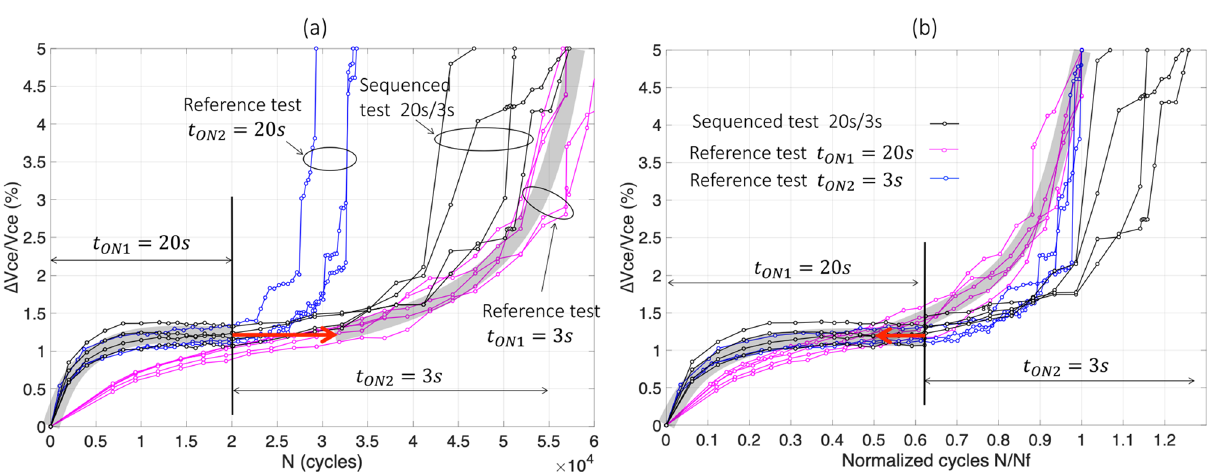
Figure 9. The sequenced test 20 s/3 s (test#10), normal scale in cycles ( a ) and normalized in N f ( b